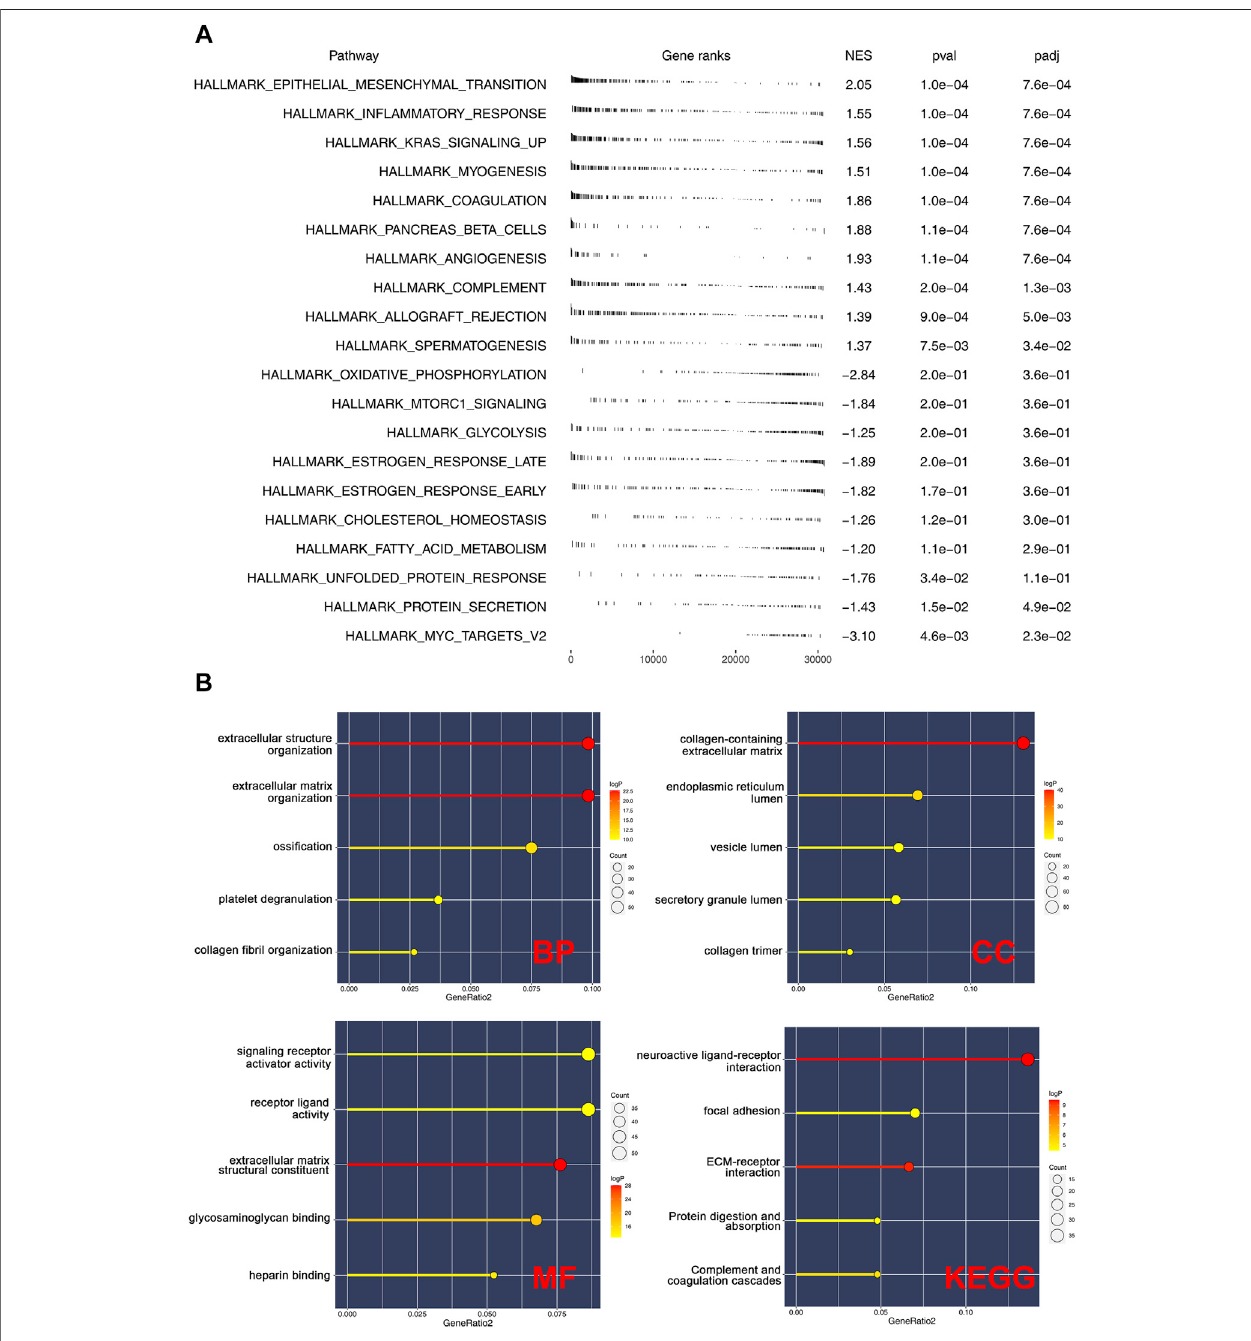
FIGURE6| Pathwayenrichmentanalysisofriskscore. (A) :GSEAwasperformedbasedontheHallmarkgeneset; (B) :GOandKEGGanalyseswereperformedto explore the biological difference between high- and low-risk patients.